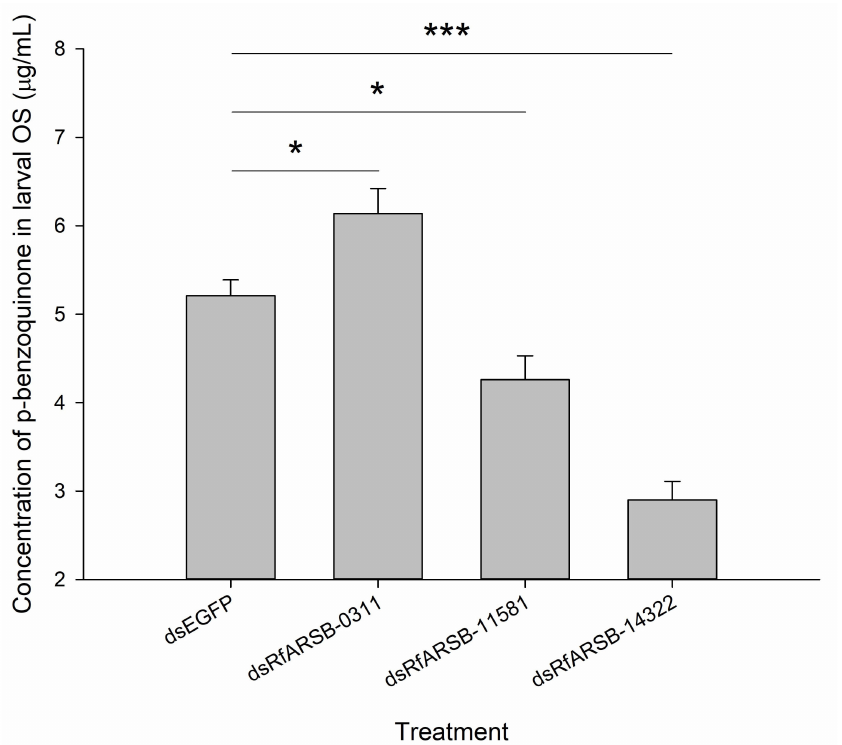
Figure 8. E ff ect of RfARSBs silencing on the quantity of p-benzoquinone in oral secretions produced by RPW larvae at 12 h after dsRNA injection. Data are shown as the mean ± SE from six independent biological repetitions. The asterisks marking the Student’s t test results indicate that there is a significant di ff erence between the treatment and the control group (*, p < 0.05; ***, p <